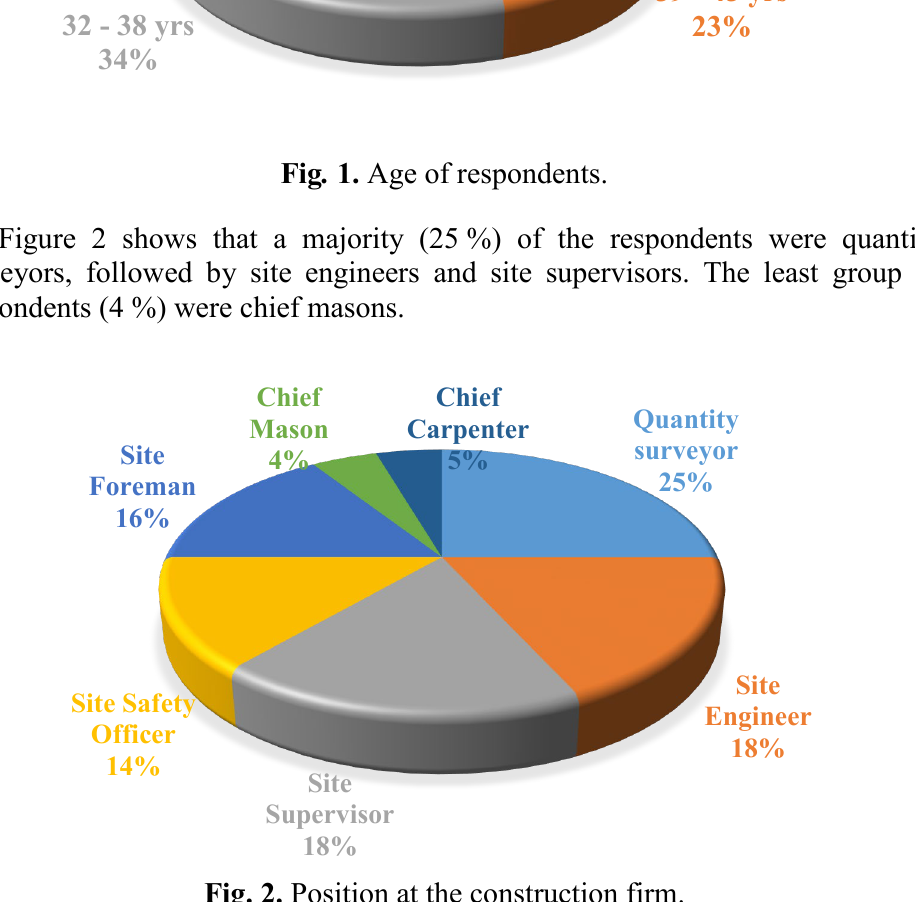
Fig. 2. Position at the construction